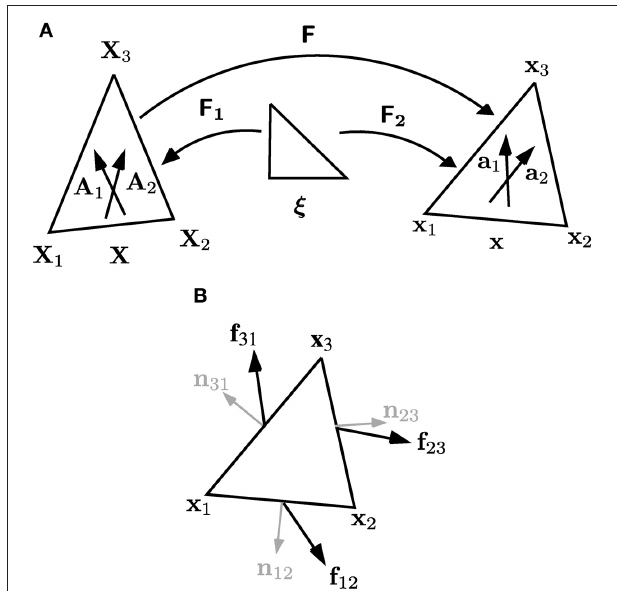
FIGURE 4 | Coordinate systems and forces for triangular elements lying within walls in the plane of the simulation. (A) Vertices of a triangular element have positions X 1 , X 2 and X 3 in the reference configuration, and x 1 , x 2 and x 3 in the current configuration. The gradient of the deformation F is calculated using F = F 2 F − 1 1 , where F 1 and F 2 are the gradients of the maps, defined by linear interpolation, from the unit triangle to the reference and current configurations, respectively. The elements each have a pair of microfibril directions, A 1 and A 2 , in the reference configuration; these are embedded in the material of the cell wall, so are deformed with it to directions a 1 and a 2 in the current configuration. (B) Notation used in Equations (16) and (17) for the forces on and normals to the edges of each triangular